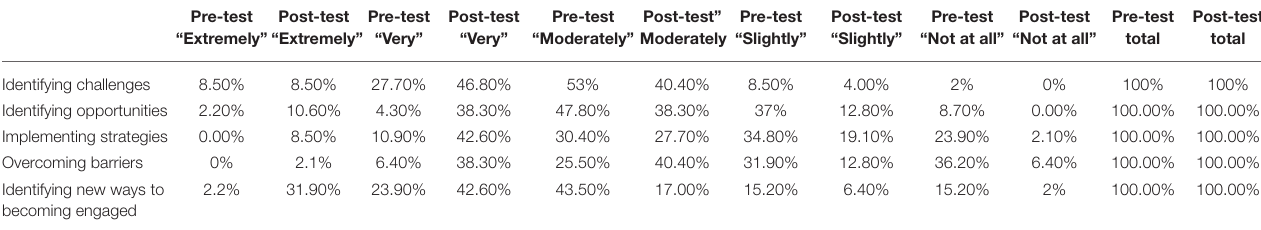
TABLE 1 | Knowledge measures.